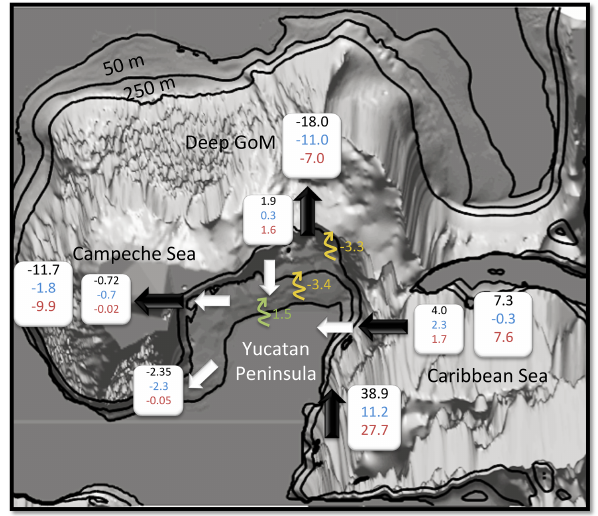
Figure 9. Scheme of the TN budget for the Yucatán shelf. Black and white arrows denote cross-shelf flux for the outer and inner shelf, re- spectively. In blue is the PON, in red the DIN, in green the freshwa- ter DIN sources (Rivers), and in yellow the sinks of TN due to den- itrification (DNF). The values are expressed in molNyr − 1 × 10 10 . Negative values indicate sink, whereas positive indicates a source of TN. The isobaths that delimit the inner (50m depth) and outer (250m depth) shelves are also highlighted.